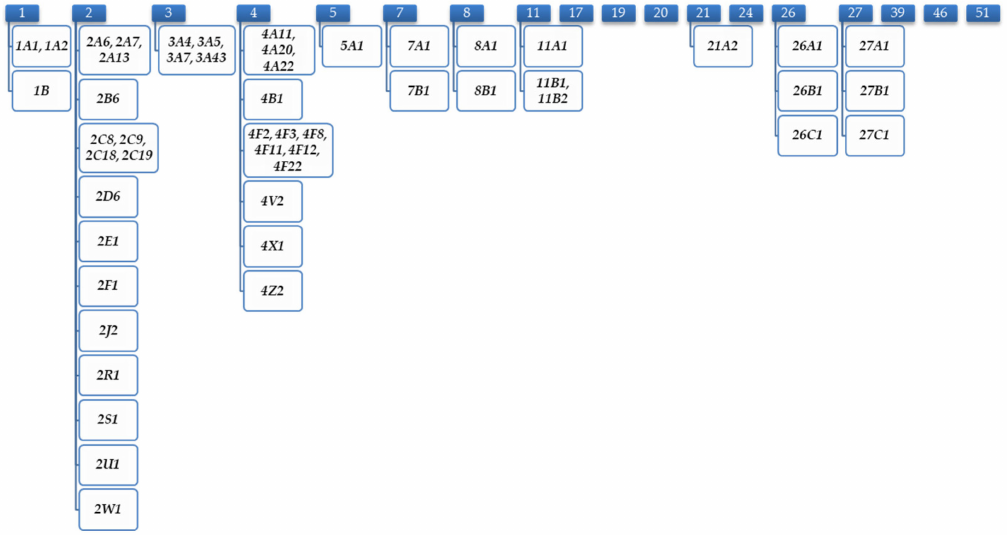
Figure 1. CYP pattern of cytochrome P450 hemoproteins in the human